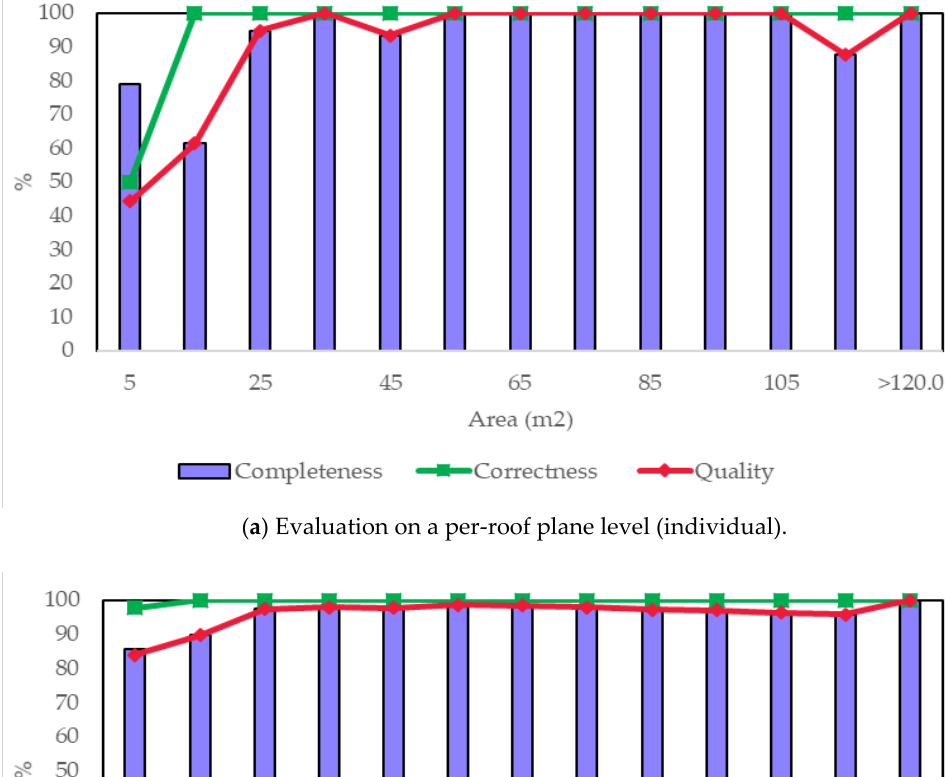
Figure 21. Evaluation on a per-roof plane level between the object size and reconstruction quality—individual ( a ) and cumulative ( b ).